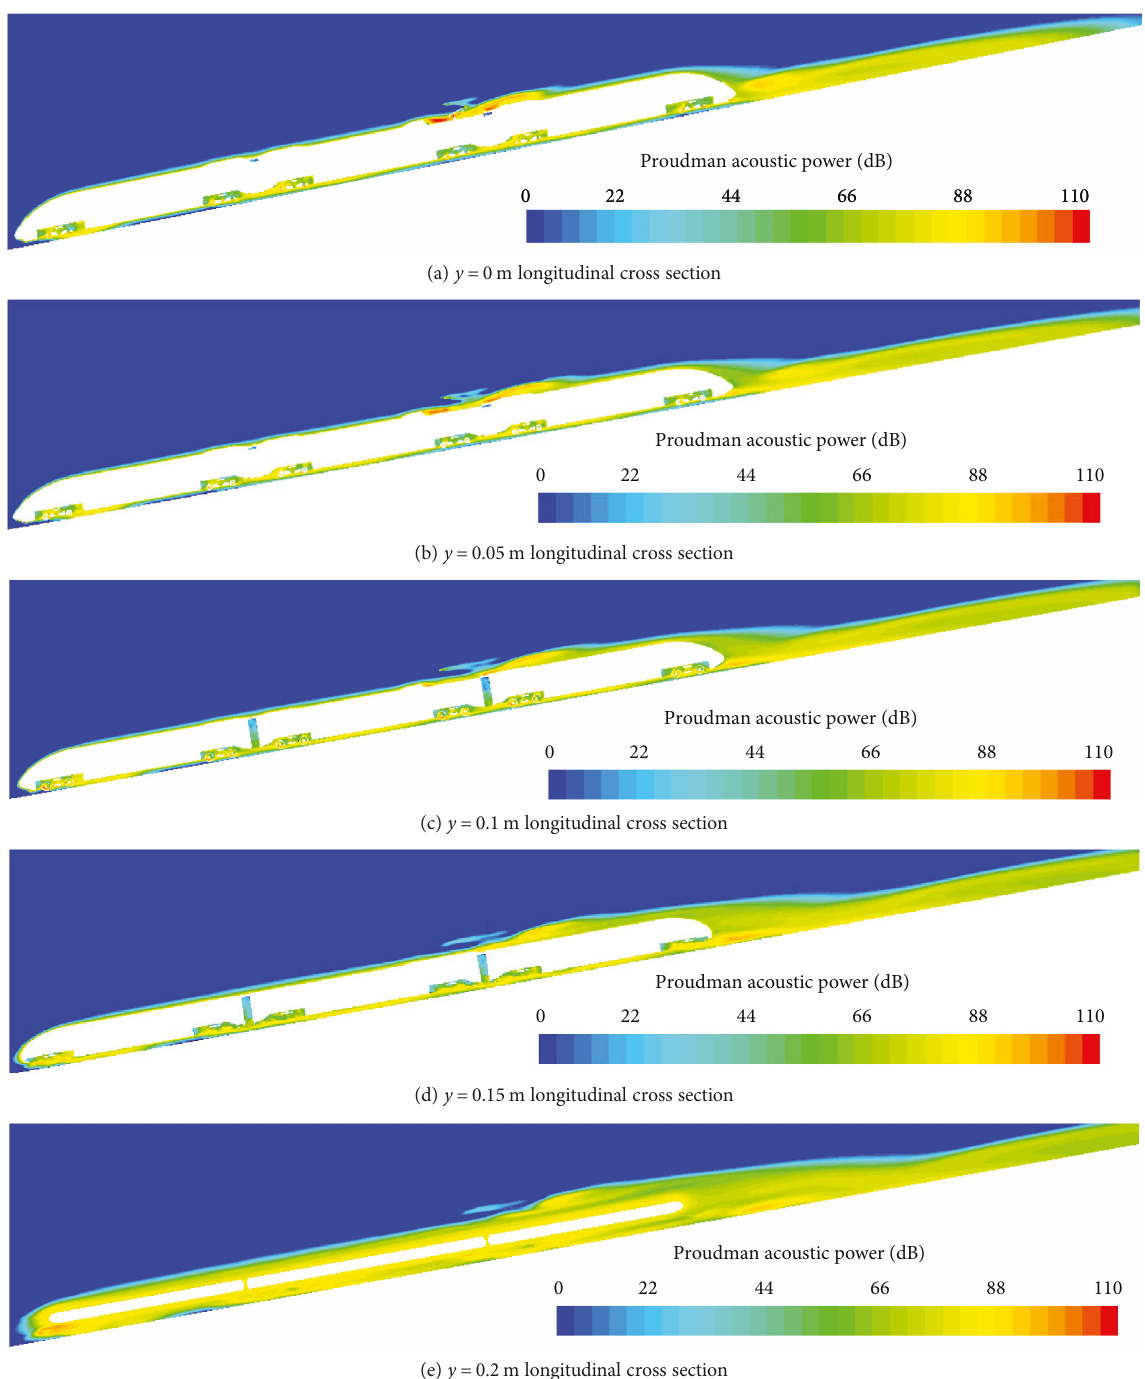
Figure 11: Quadrupole noise around the high-speed railway on